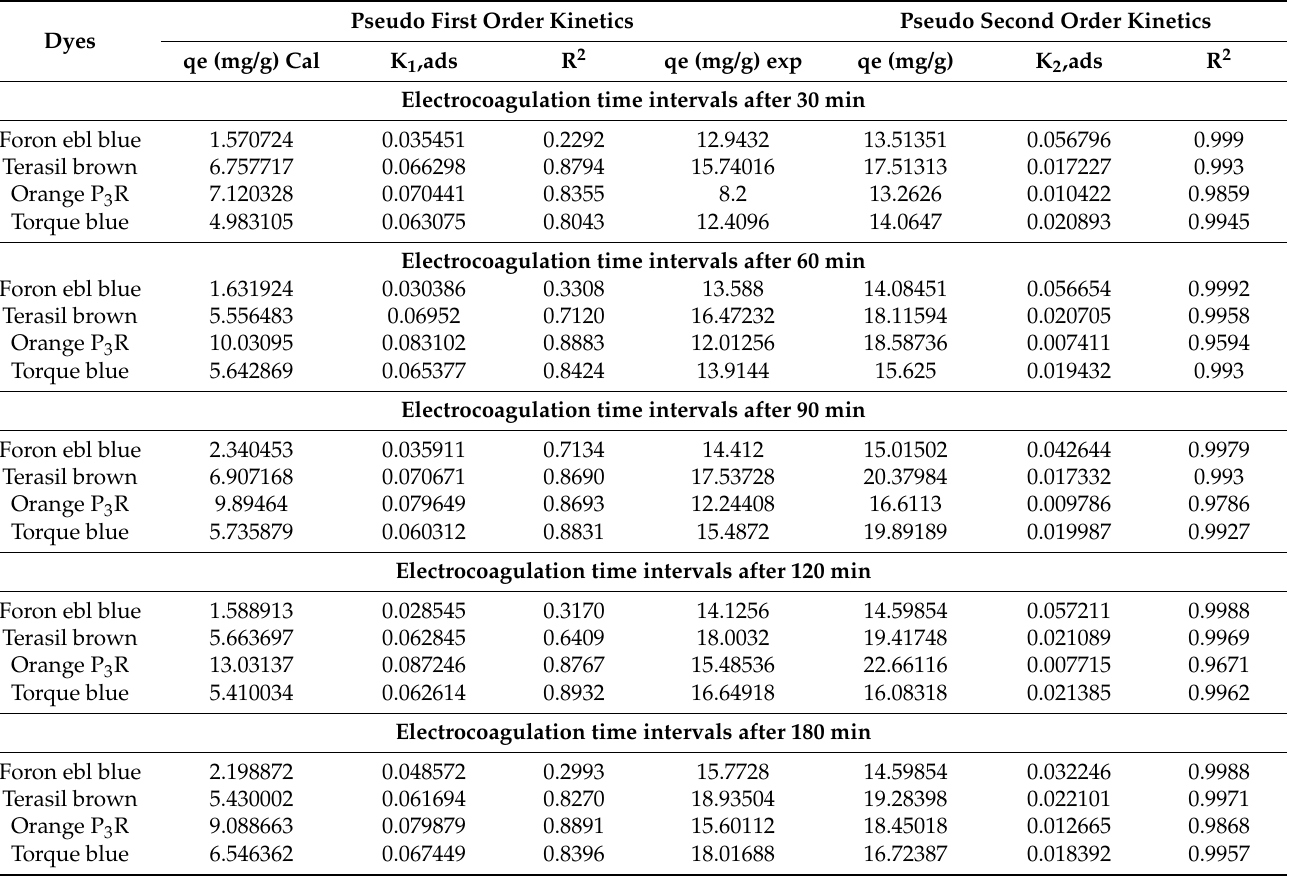
Table 4. Pseudo first and second order kinetics parameters of all dyes at 5 electrocoagulation time intervals (5, 10, 15, 20, 30 min) for every shaking time by calcinized